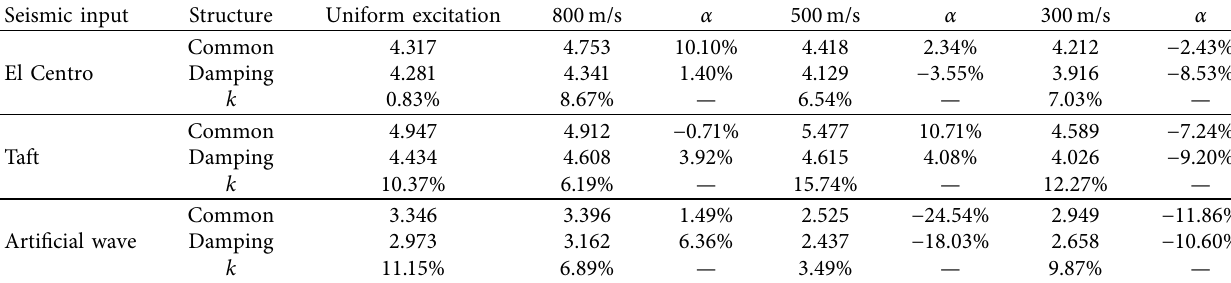
Table 5: Displacement of the main structures’ top.